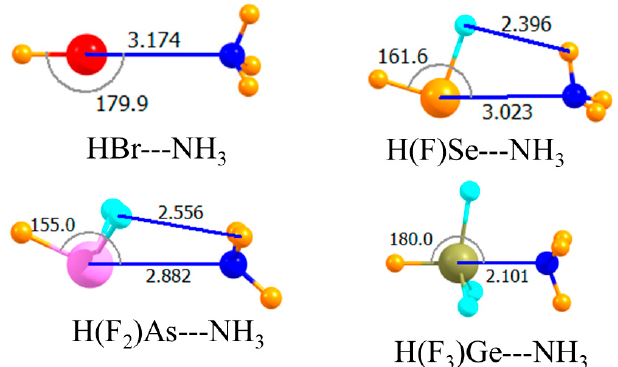
Figure 3. Optimized geometries of complexes involving a partially fluorinated Lewis acid with H opposite N. Intermolecular distances are in Å, angles in deg.